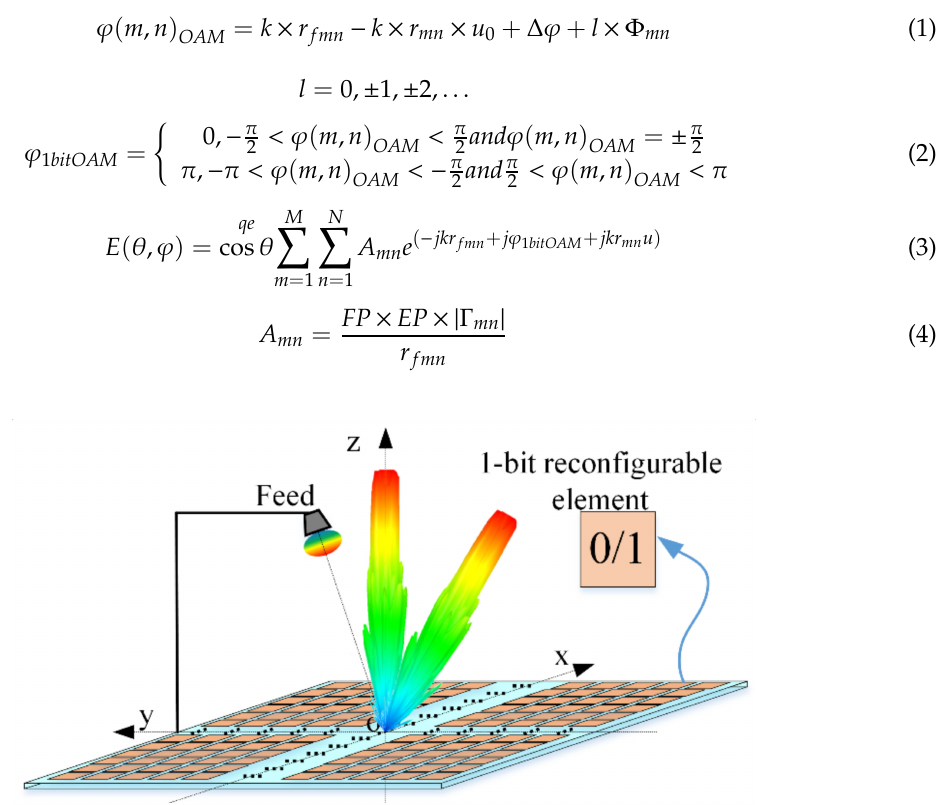
Figure 1. Schematic diagram of a reflectarray antenna for orbital angular momentum